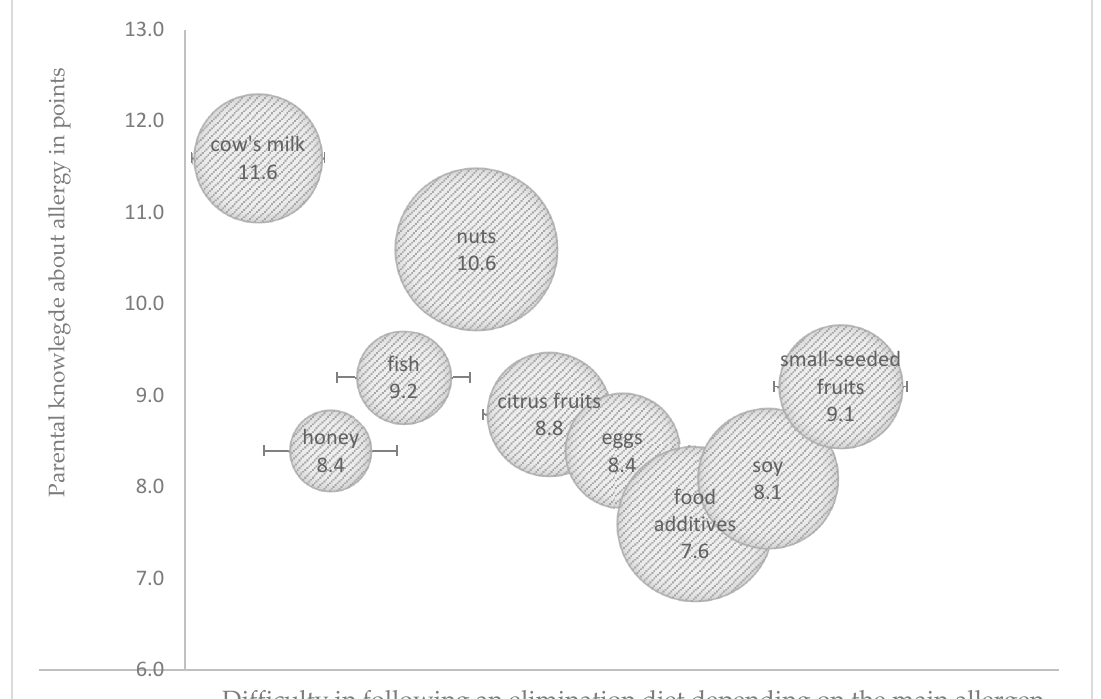
Figure 1. Influence of parental knowledge score (in points) on difficulties in following an elimination diet depending on the main allergen (the size of the bubble corresponds to the degree of difficulty in following the elimination diet as perceived by parents).